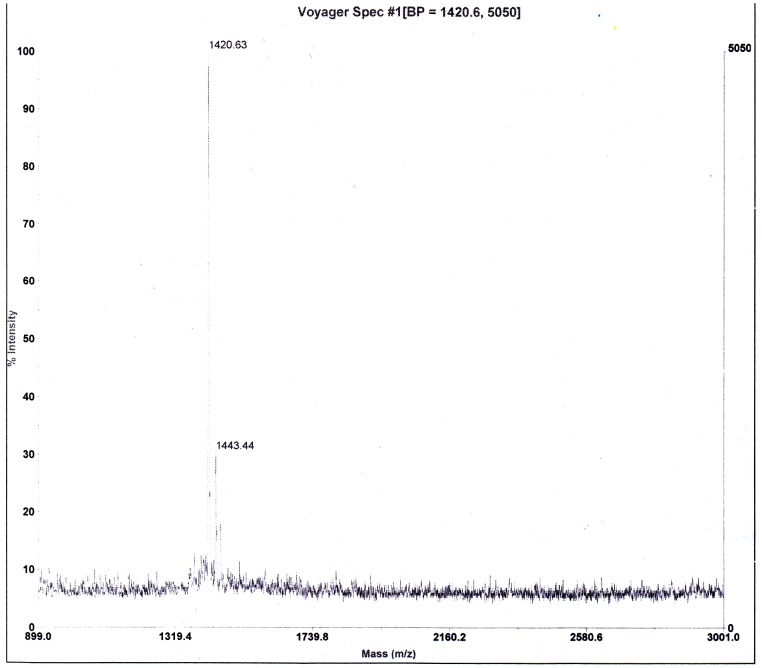
MS result.Mass Spectrometry result of cyclic RRL showed accurate peptide sequence.